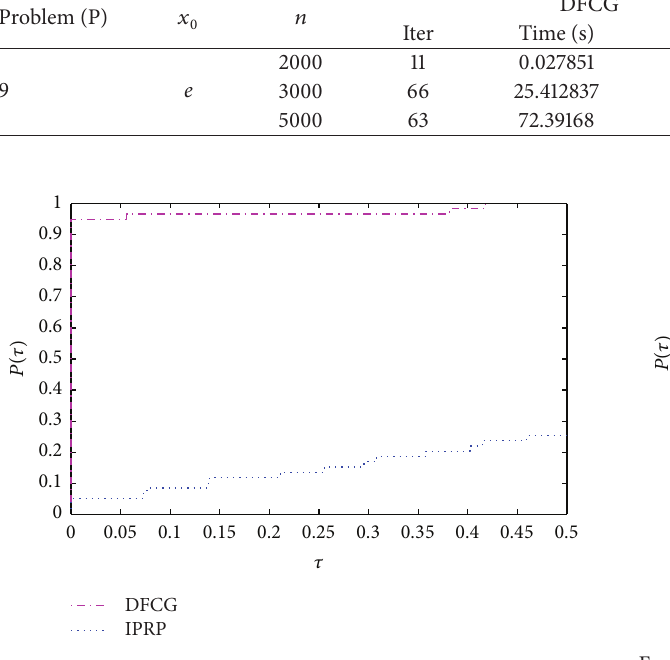
Figure 1: Comparison of the performance of DFCG and IPRP methods as the dimension increases (in terms of CPU time).